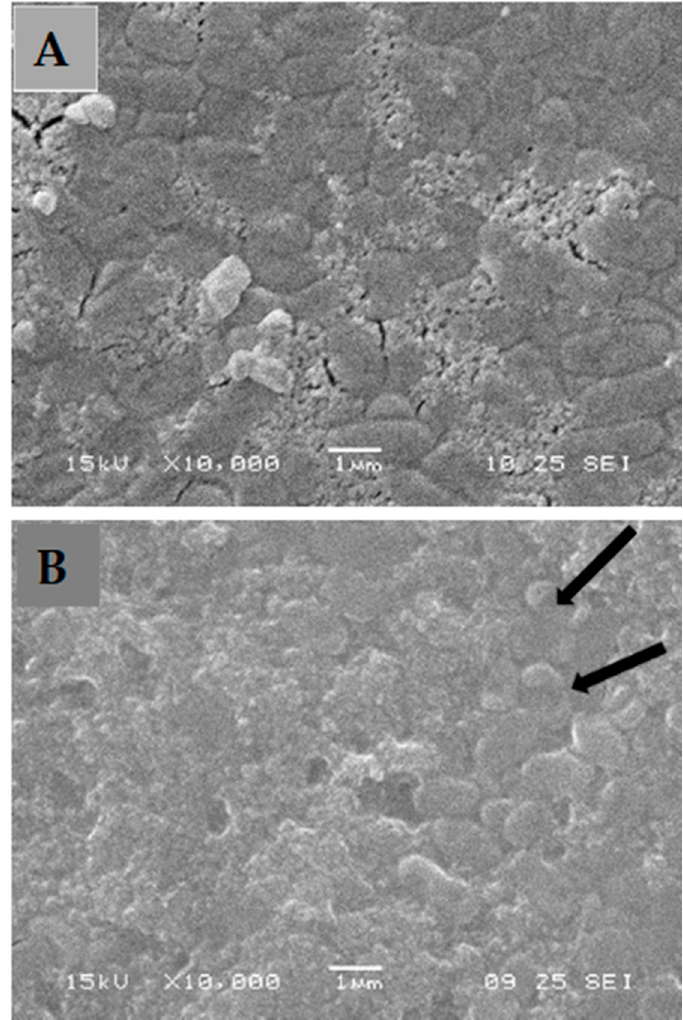
Figure 5. SEM image of a biofilm of Pseudomonas aeruginosa : ( A ) treated with Pc+ in the non-irradiated test containing a photosensitizer concentration of 1.0 × 10 − 4 M—dark toxicity (L- Ps+), and ( B ) treated with Pc+ at a concentration of 1.0 × 10 − 4 M and irradiated by light dose of 3.6 J/cm 2 —photocytotoxicity (L+ Ps+). Arrows indicate changes in the cellular morphology, including alterations in cellular size and structures, thus suggesting cellular rupture. (SEM × 10,000; scale bar—1 µm).